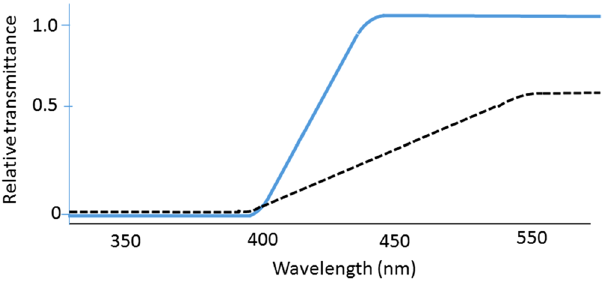
Figure 4. Spectral transmittance of the intra-ocular lens used in this study (solid line) and a 50-year-old human lens (dotted line), modified from the literature 52,53 . This intra-ocular lens (ZCB00V; Abbott Medical Optics Inc., Santa Ana, CA) was newly introduced to minimize retinal toxicity and adverse effects on circadian rhythms by filtering 100% of short-wavelength light under 420 nm and allowing longer-wavelength light, including 460 nm, to enter the implanted eye 57